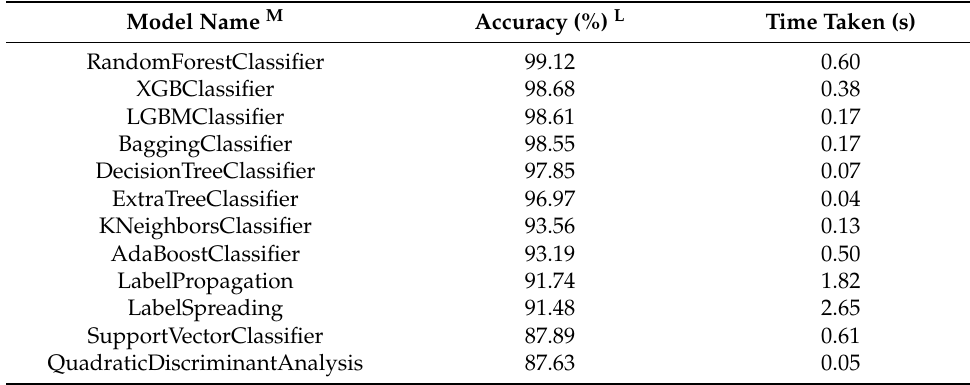
Table 1. Accuracy benchmarks and time taken to build each of the selected 26